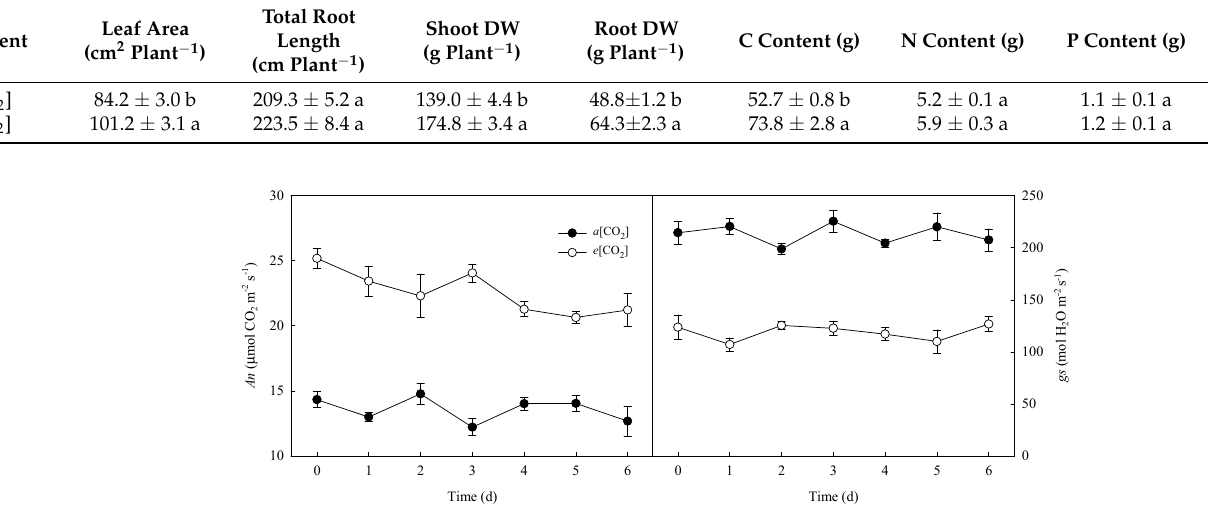
Figure 3. Photosynthetic rate ( An ) and stomatal conductance ( g s ) in leaves of Phragmites australis grown under ambient ( a [CO 2 ], 400 ppm) and elevated ( e [CO 2 ], 800 ppm) atmospheric CO 2 concen- trations in six consecutive days. Data are expressed as means ± SEM (n = 3).